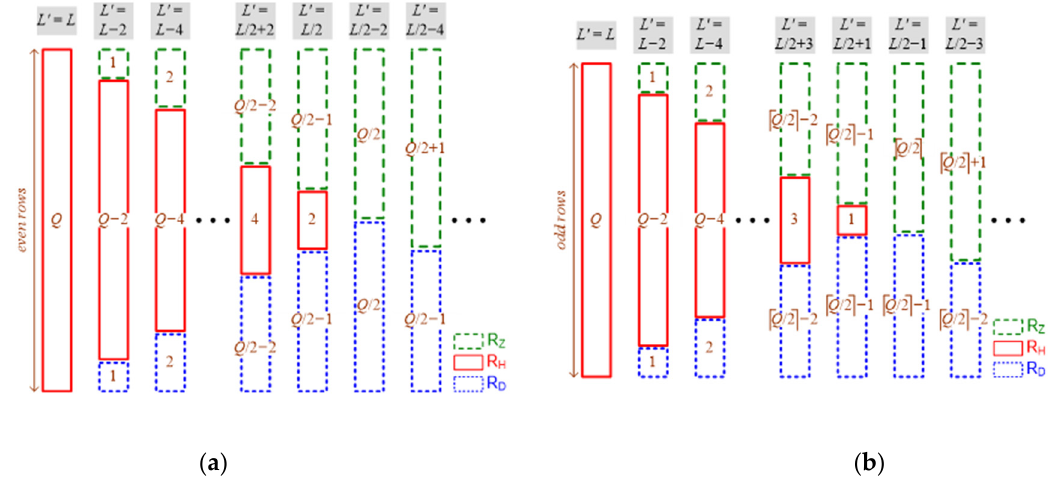
Figure 5. Schematic for the R Z /R H /R D distribution of TP minor rows of a general L -bit Booth multiplier for various L (cid:48) -bit inputs: ( a ) L = 2 n , and n is even; ( b ) L = 2 n , and n is